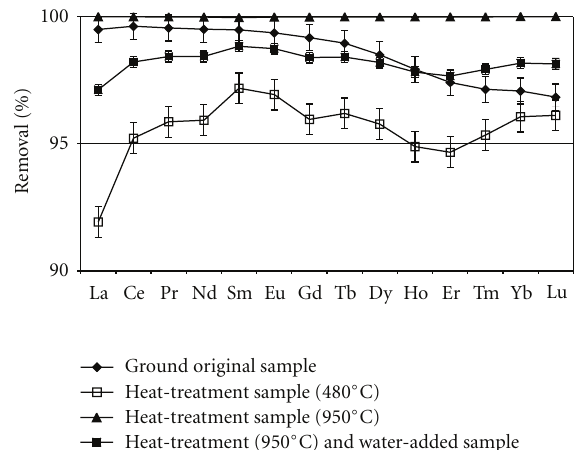
Figure 3: Comparison for sorption capacity of lanthanides by four kinds of sieved Buccinum tenuissimum shell samples.